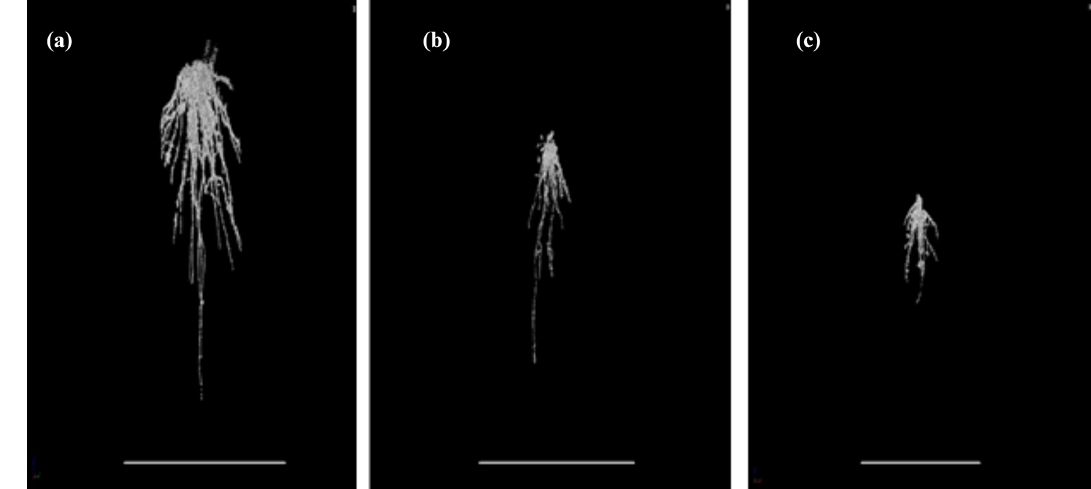
Figure 6. The root system architecture of winter wheat during anthesis for (a) deep-tillage no-traffic systems, (b) zero-tillage low-tyre- pressure systems, and (c) deep-tillage conventional-tyre-pressure systems. Panels (a) and (b) show a significantly longer root length on the primary axis compared with the deep-tillage trafficked treatments shown in panel (c) . The scale bar represents